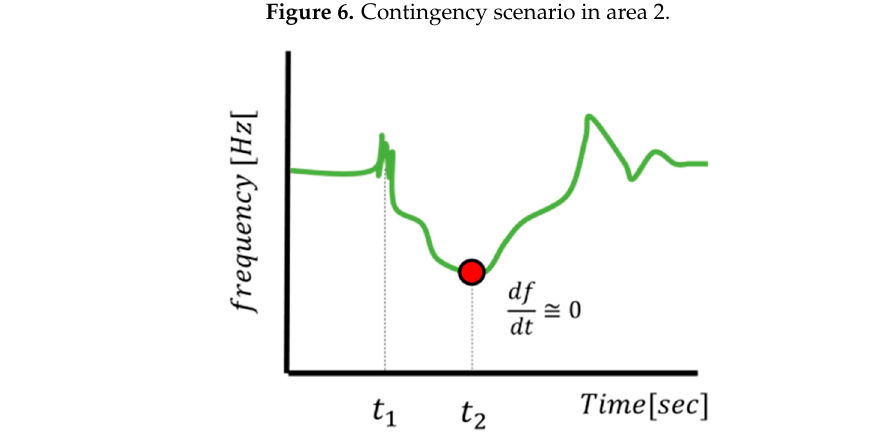
Figure 7. Frequency drop during a contingency event in area 2.